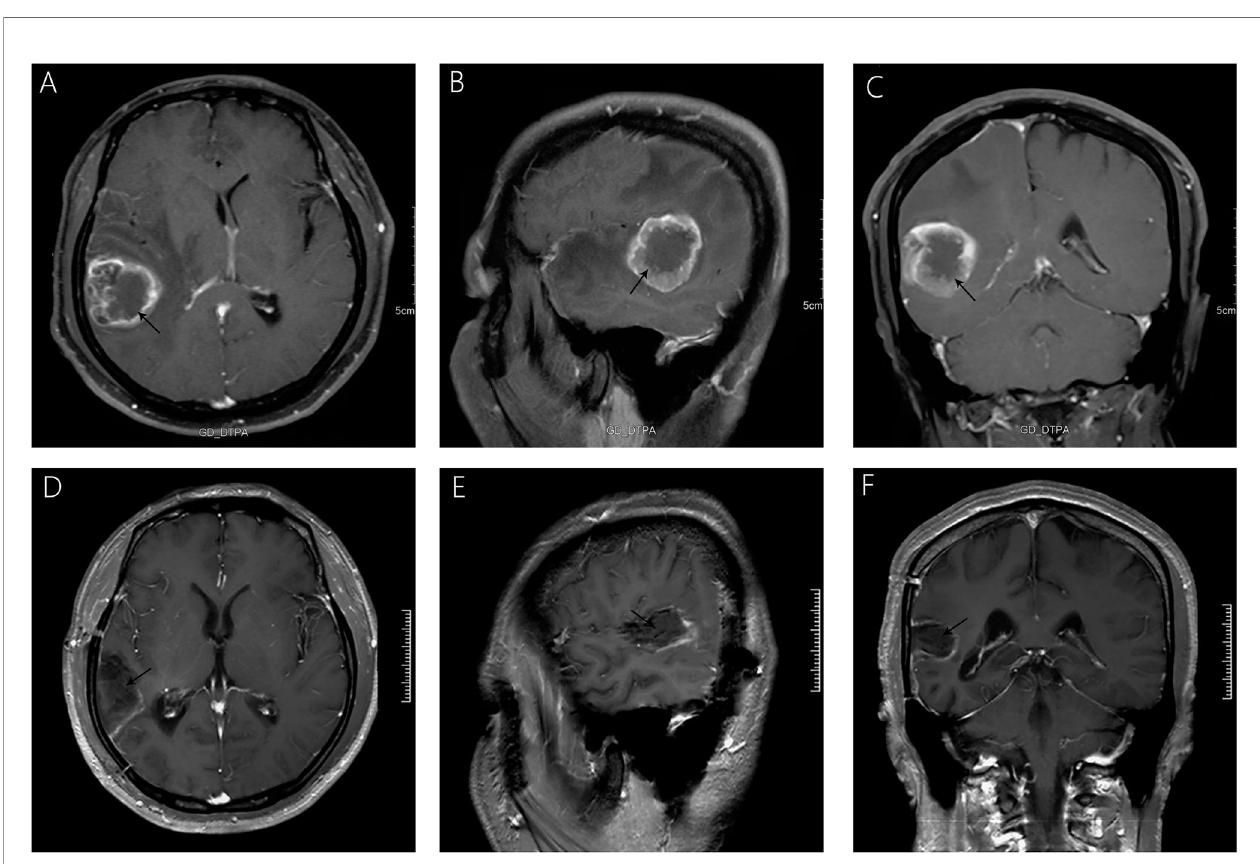
FIGURE 1 | Signi fi cant heterogeneous enhancement is observed with evident edema after gadolinium administration (A – C) . A follow-up MRI, 3 months after surgery (D – F), showed that the lesion was completely removed, without any signs of